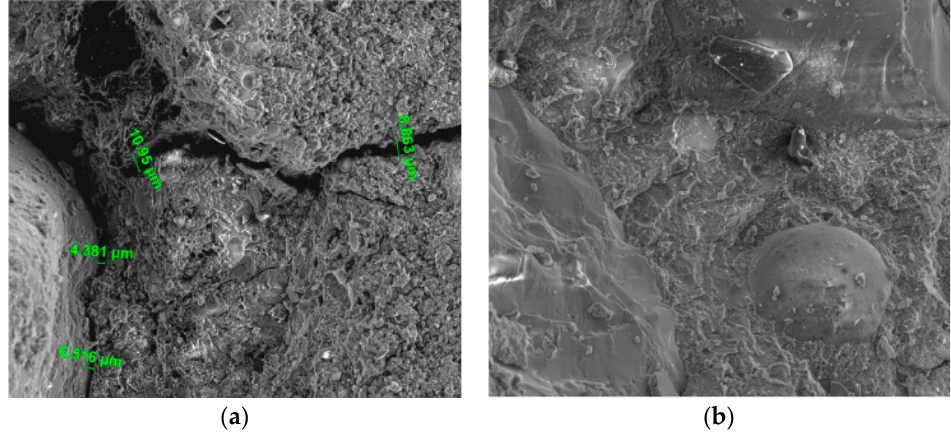
Figure 7. SEM images of concrete ( a ) without and with ( b ) 1% CNCs (1000 × magnification). Reproduced from [27], with permission from Elsevier, 2019.